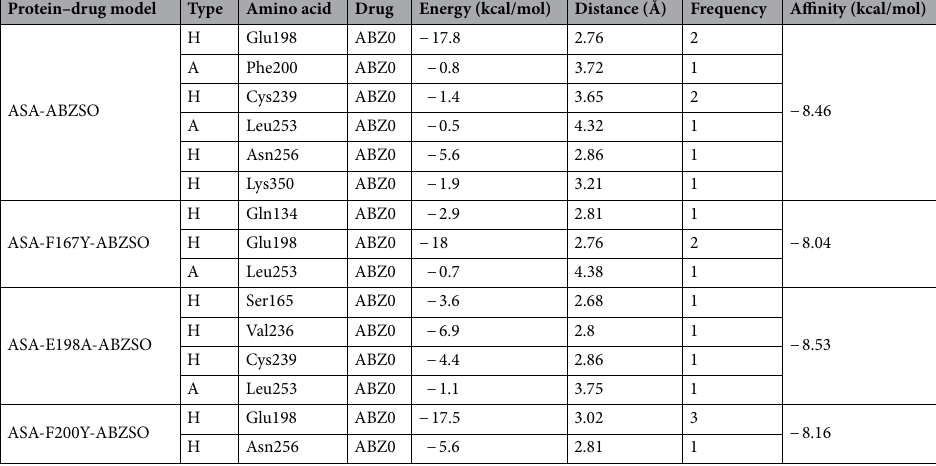
Table 1. Interactions between albendazole sulfoxide and specific amino acids in Ascaris suum β-tubulin proteins. The proteins used in these analyses were Ascaris suum β-tubulin ASA, the three mutated ASA proteins. The table shows the type of bonds formed (H—hydrogen bond, A—arene bond), the amino acid the bond is formed with, and the drug used. The energy of the bonds between the amino acid and drug are given in kcal/mol, the distance between the bonded atoms is given in Angstroms (Å) and the number of bonds formed between the amino acid and the drug is shown (frequency). The overall drug binding affinity is given in kcal/mol. ASA = Ascaris suum β-tubulin isotype A, ABZSO = albendazole sulfoxide.